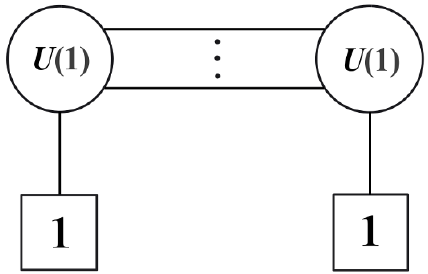
Figure 3. The 3d mirror of ( A 1 ; D 2 N ) theories. There are N (cid:0) 1 hypermultiplet between two U(1) gauge nodes, and there are additional one hypermultiplet charged under each